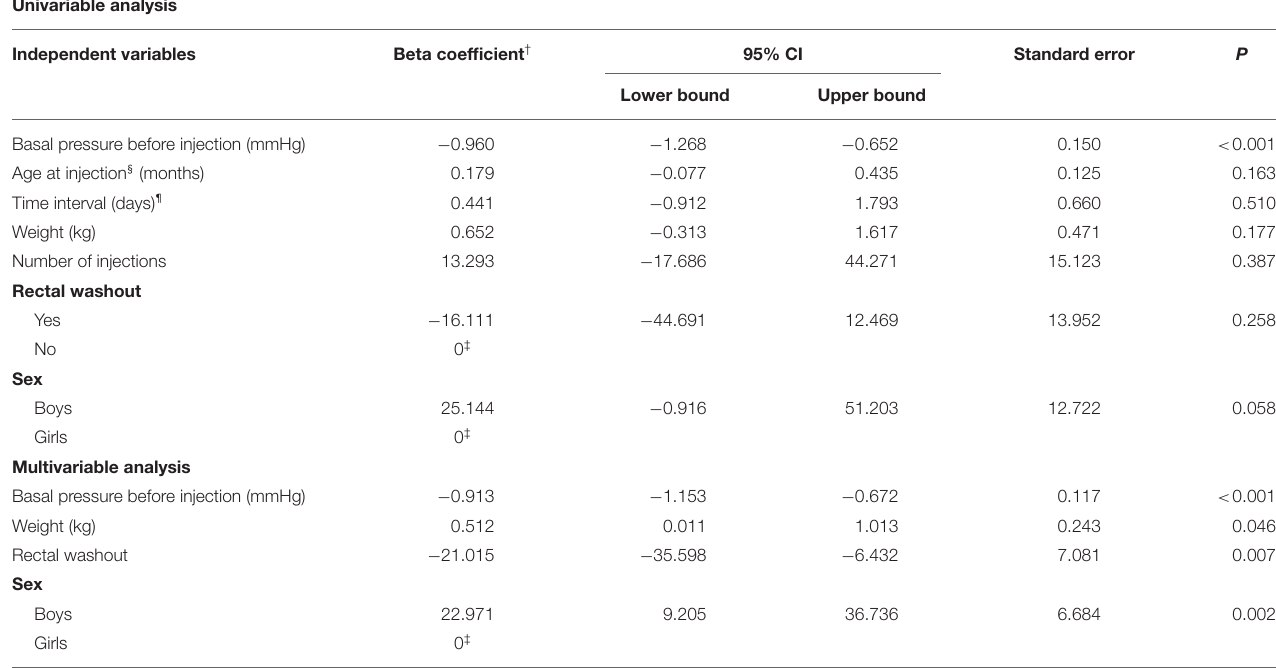
TABLE 3 | Univariable linear regression analyses of factors that could influence changes in anal basal pressure change in cases with idiopathic constipation ( n = 30). Univariable